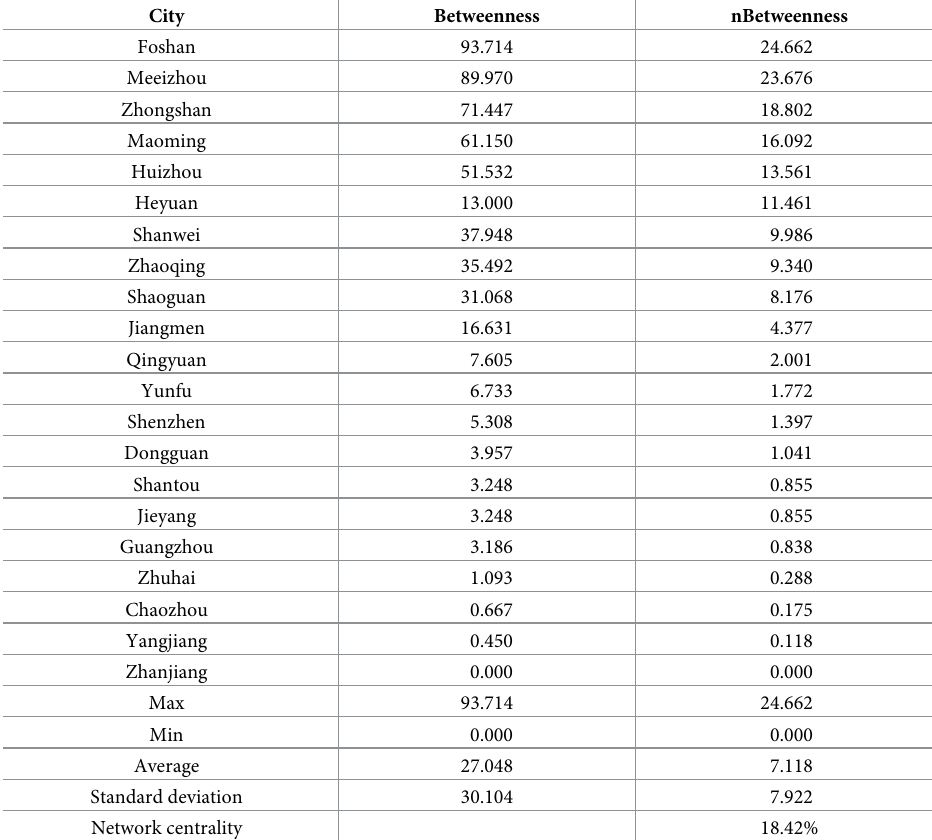
Table 8. Betweenness centrality of the spatial correlation